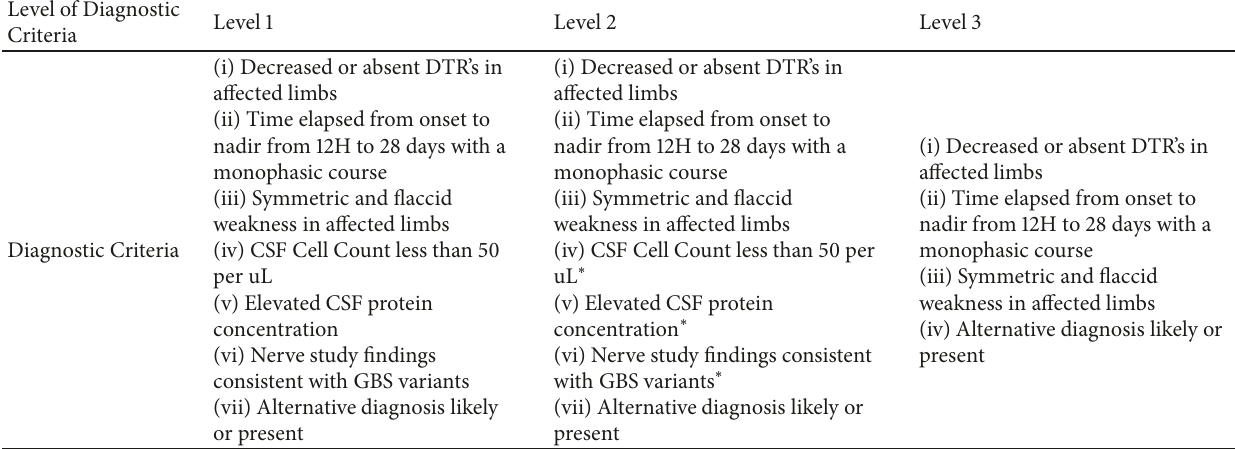
Table 1: Brighton diagnostic case